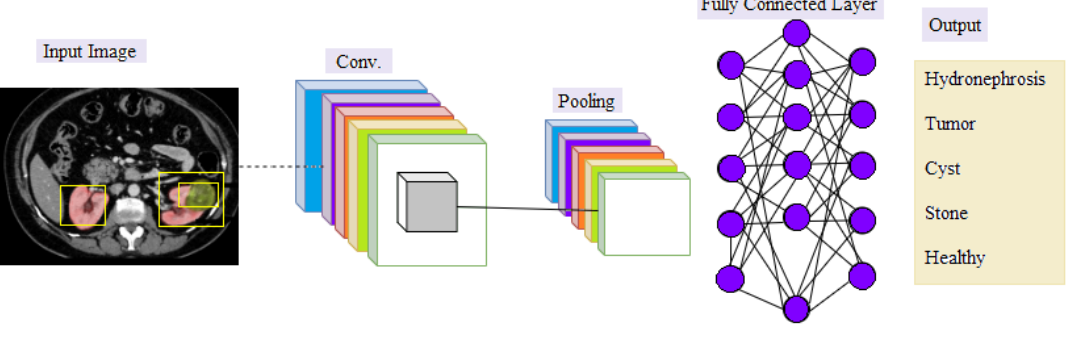
Figure 7. Architecture of a traditional